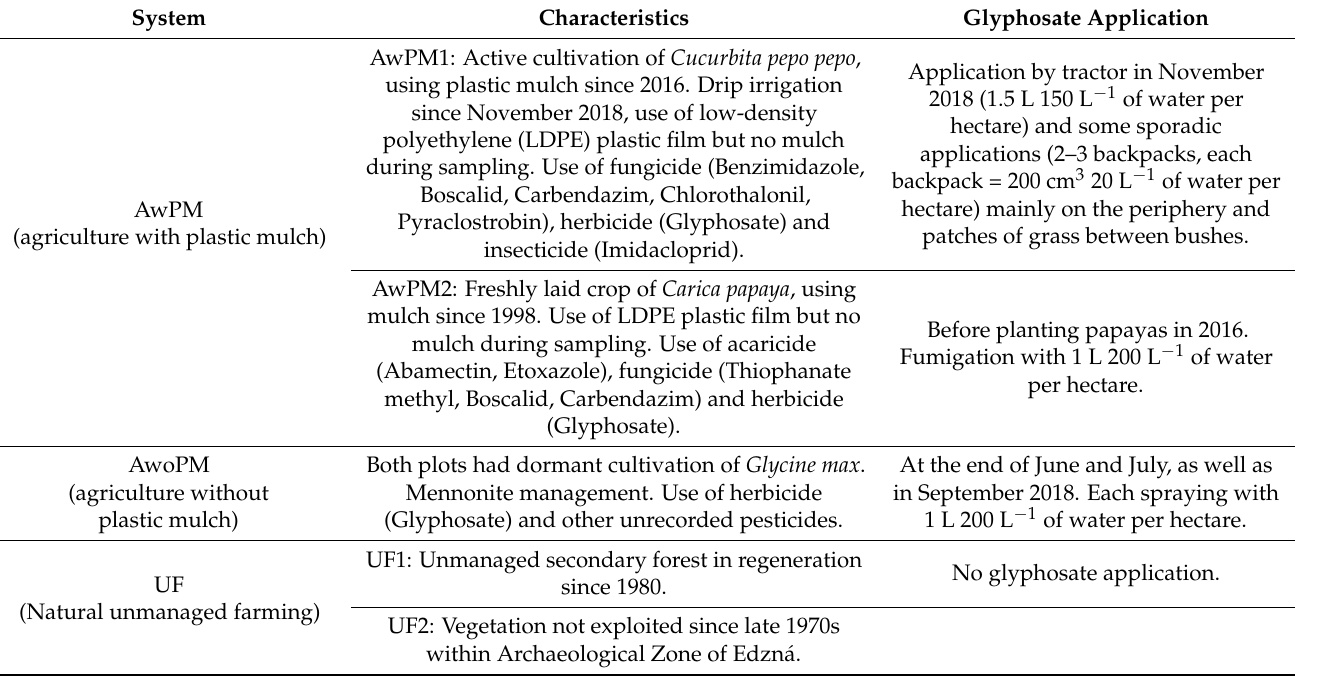
Figure 1. Location of the study area and the plots with the different production systems. AwPM = Location of the study area and the plots with the different production sys- agriculture system with plastic mulch and GLY; AwPM = agriculture with plastic mulch and GLY; tems. AwPM = agriculture system with plastic mulch and GLY; AwPM = agriculture with plas- tic mulch and GLY; AwoPM = agriculture without plastic mulch and the use of GLY; Table 1. Study site characterization in Alfredo V. Bonfil, Campeche, Mexico. UF = unmanaged farming system. Table 1. Study site characterization in Alfredo V. Bonfil, Campeche,